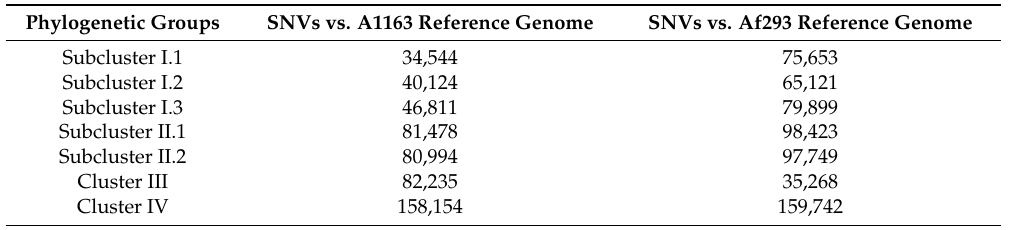
Figure 2. Whole genome phylogenetic analysis of 101 Aspergillus fumigatus genomes included in the study. Dendrogram was performed using A1163 as reference genome. Table 3. Mean of single nucleotide variants (SNVs). Variants within clusters and subclusters compared to both reference